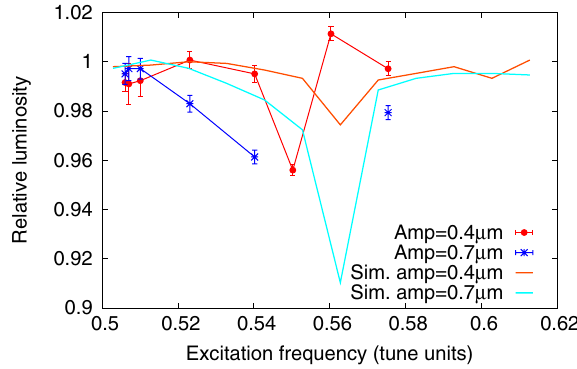
FIG. 12. Relative luminosity versus frequency of the harmonic excitation for two excitation amplitudes, both from measure- ments and simulations. The experimental points are connected with lines to guide the eye where considered